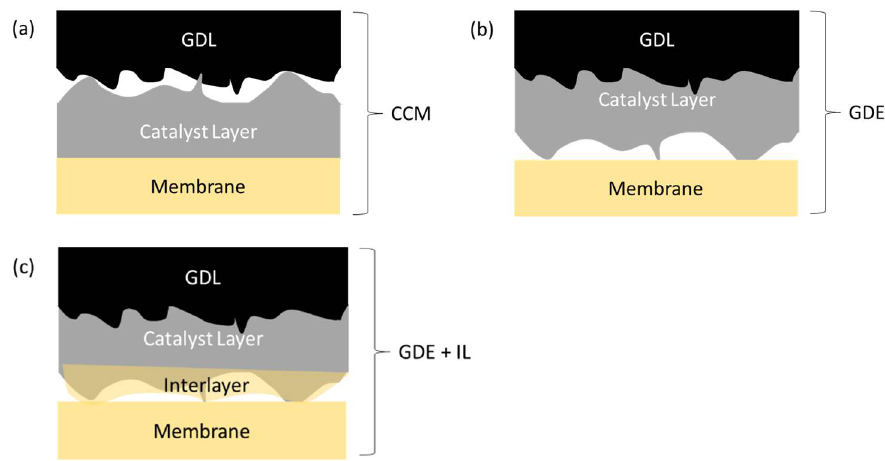
Figure 9. Schematic close-up of cross-sections of non-hot-pressed MEA’s generated by ( a ) CCM ( b ) GDE and ( c ) GDE + interlayer (“IL”) methods, illustrating the likely imperfections in the desired intimate contact between each of the layer interfaces. Note that the membrane surface, consisting of recast polymer (ionomer), can typically be made with lower roughness than GDL or CL surface consisting of stacked nanoparticles.